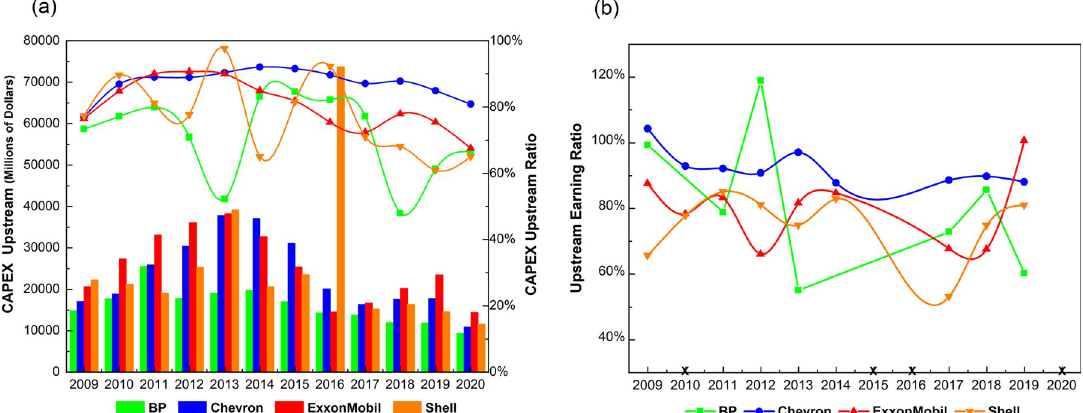
Fig 4. Upstream CAPEX and earnings. (a) Upstream CAPEX (2009~2020) (b) Upstream earnings ratio (2009~2020). Note: BP, Shell, and Chevron incurred negative earnings in 2015 and 2016, due to decreased oil prices. In 2020, all four majors suffered huge losses upstream and across the whole business chain due to reduced oil demand during the COVID-19 pandemic. Trends in these three years should thus not be taken into account. BP also incurred huge losses in 2010 due to the oil leak in the Gulf of Mexico. In 2013, because of the loss of downstream and other business, BP’s total earnings reached only $4,950 million, though upstream earnings were $8,848 million. BP’s earnings ratio during these two years should therefore also be